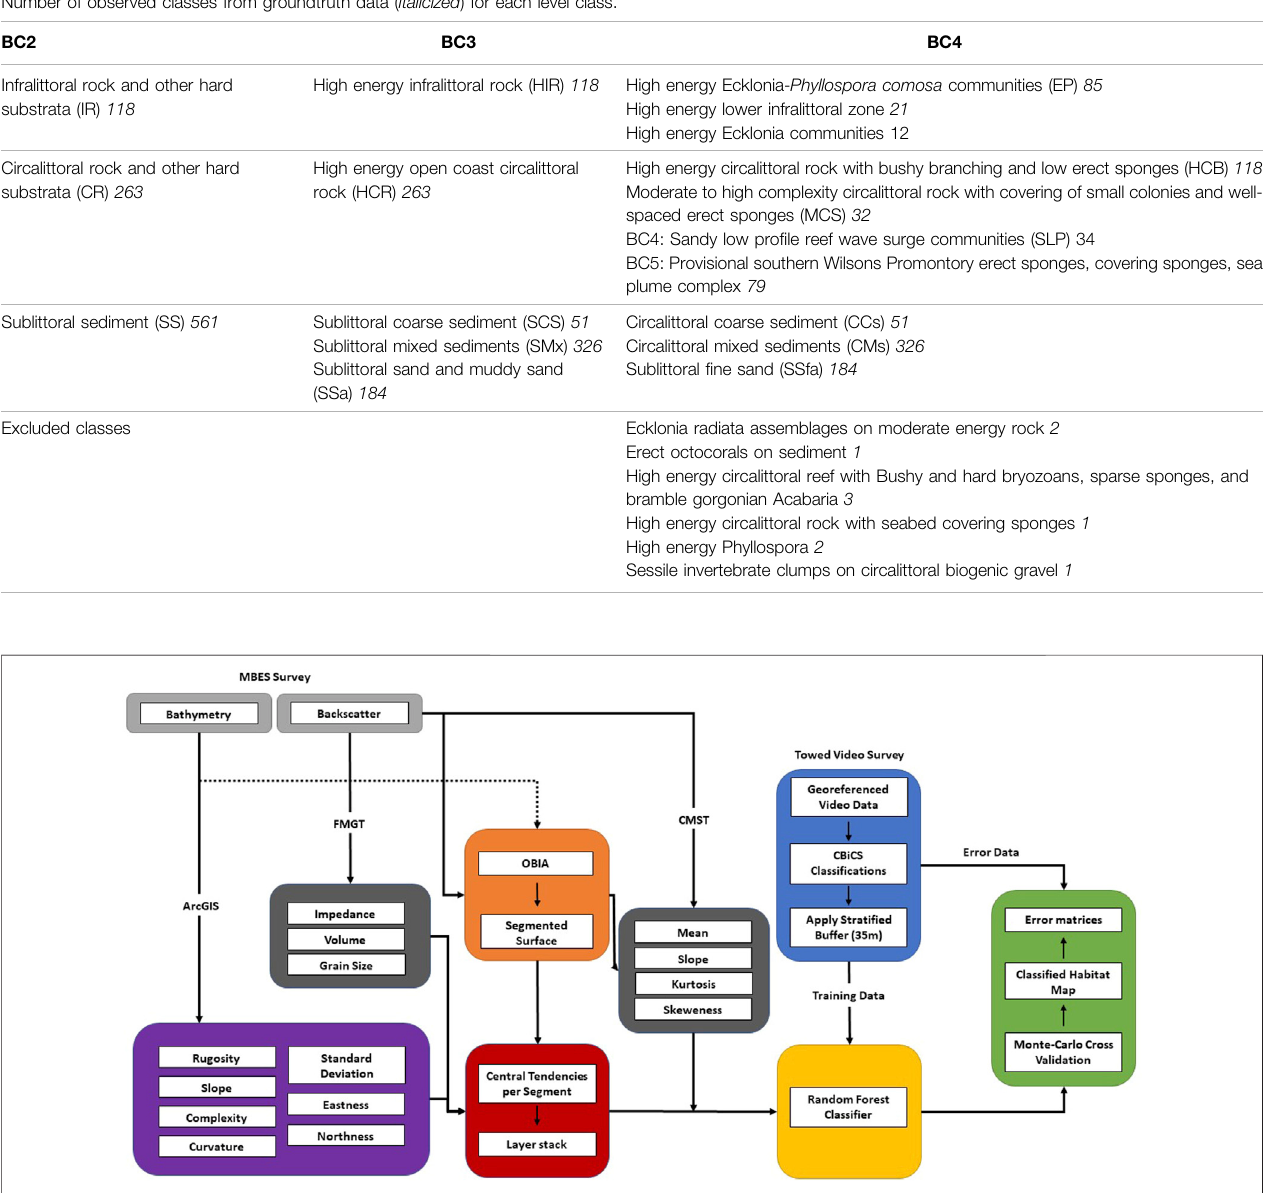
FIGURE 2 | Flowchart depicting analysis options for Bathymetry, backscatter AR and ARA.